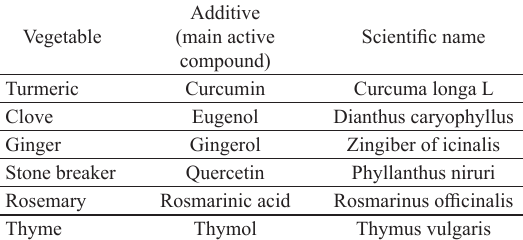
Table 2. Analyzed compounds and the respective sources from which they were obtained, in addition to the scientific name of the